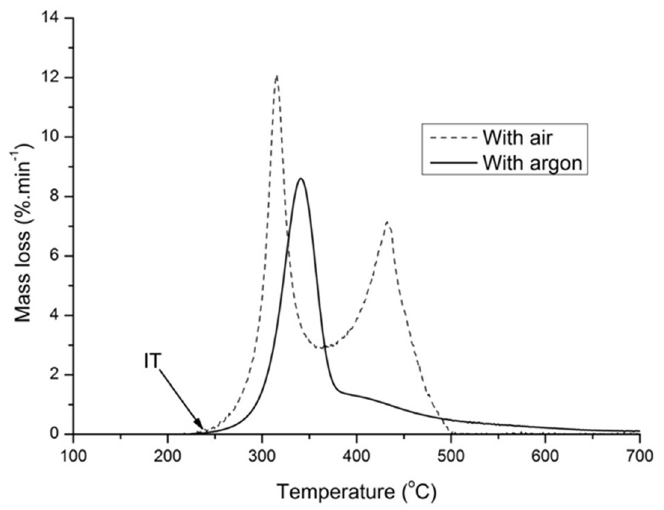
Figure 2. Derivative mass loss curve for TM300 (torrefied miscanthus at T t = 300 °C